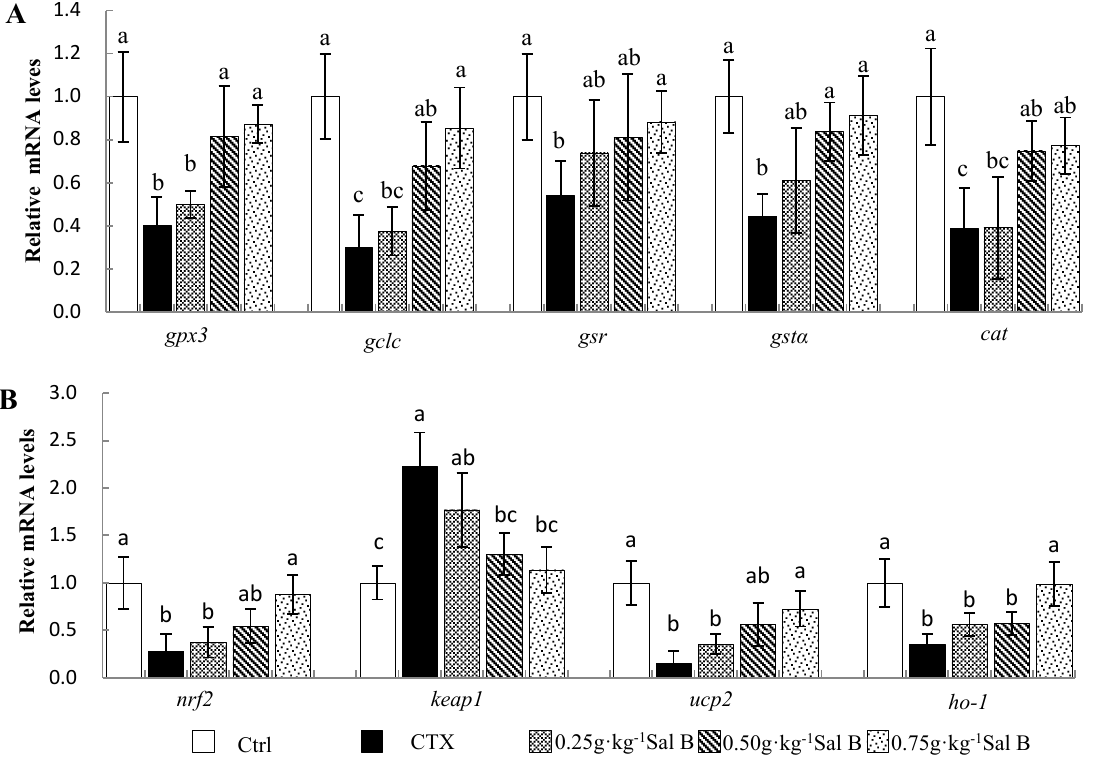
Figure 3. Effects of Sal B on antioxidant and Nrf2-pathway-related gene mRNA levels in liver samples of Nile tilapia: ( A ) expression of antioxidant-related genes; ( B ) expression of Nrf2-pathway-related genes. The values are means ± SE ( n = 8). a,b,c Different superscript letters for each parameter indicate significant differences ( p < 0.05).